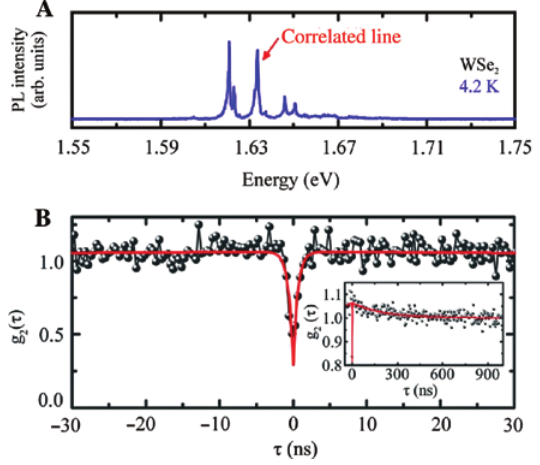
Figure 13: (Left panel) Polarization-resolved photoluminescence spectra of a 1L WSe to the layer (right panel). The degree of polarization measured as a function of the magnetic field applied perpendicular to the WSe increase of the polarization degree when a tiny magnetic field is applied. Adapted from Ref. [12].